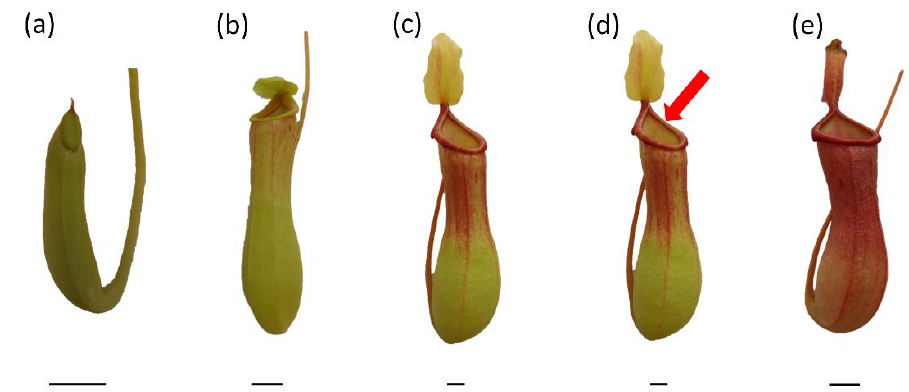
Figure 7. Traps of Nepenthes × ventrata at various stages of development: closed trap ( a ), just-opened trap ( b ), fully developed, non-artificially fed trap ( c ), fully developed trap artificially fed with two fruit flies ( Drosophilla melanogaster ) or egg-white solution ( d ), and aged trap ( e ). Bar = 1 cm.